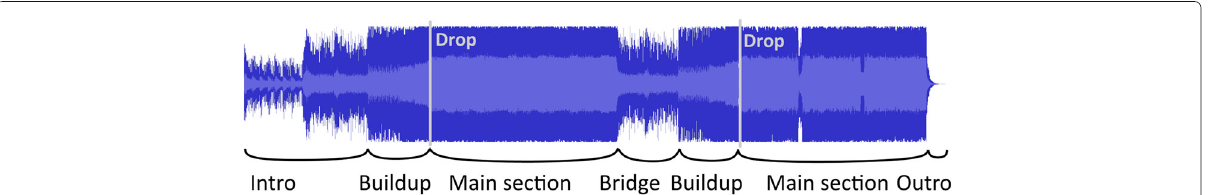
Fig. 2 Example of the compositional layout of a Drum and Bass song ([3], pp.287–292). A song typically starts with an intro , followed by a build-up that gradually increases the musical tension. This tension is released in a moment called the drop , which is the beginning of the mainsection